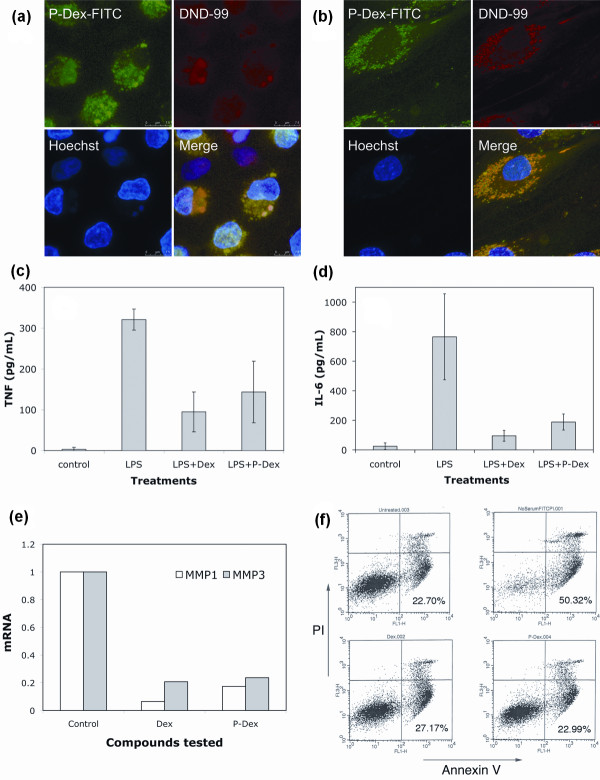
Internalization and biological effects of acid-labile N-(2-hydroxypropyl)methacrylamide copolymer-dexamethasone conjugate in cultured human cells. Confocal images show the internalization and lysosomal localization of FITC-labeled acid-labile N-(2-hydroxypropyl)methacrylamide copolymer-dexamethasone conjugate (P-Dex) by (a) cultured human monocytes and (b) fibroblasts. In the human monocyte cultures, the internalized P-Dex represses lipopolysaccharide (LPS)-mediated production of (c) TNFα and (d) IL-6 to levels comparable with those found with free dexamethasone (Dex) (n = 3, P < 0.0002). (e) In synovial fibroblasts from a rheumatoid arthritis patient, P-Dex suppresses TNFα-induced expression of matrix metalloproteinases (MMP1 & MMP3) mRNA. (f) Human monocyte apoptosis was detected in untreated monocytes (upper left panel), and was greatly increased after serum withdrawal for 24 hours (upper right panel). Neither Dex (lower left) nor P-Dex (lower right) increased apoptosis above basal levels.